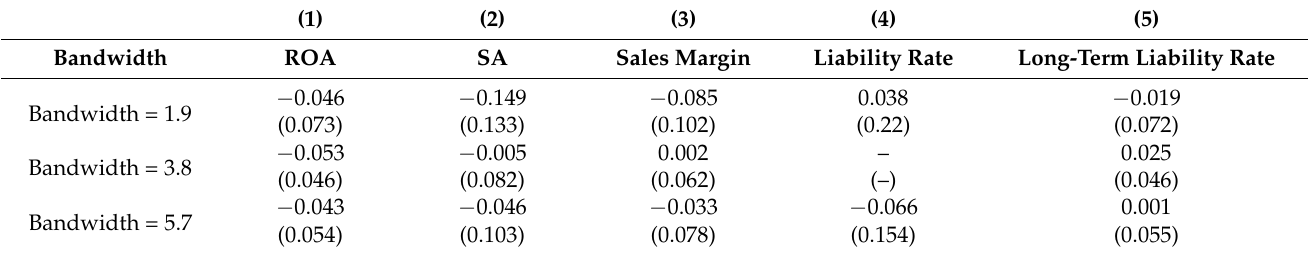
Table 8. Alternative Explanation: Impact of the tax collection reform on financial